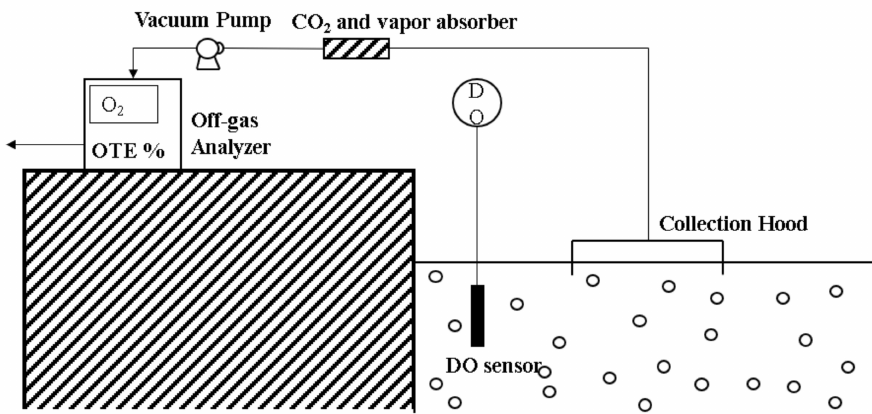
Figure 3. The schematic diagram of the off-gas